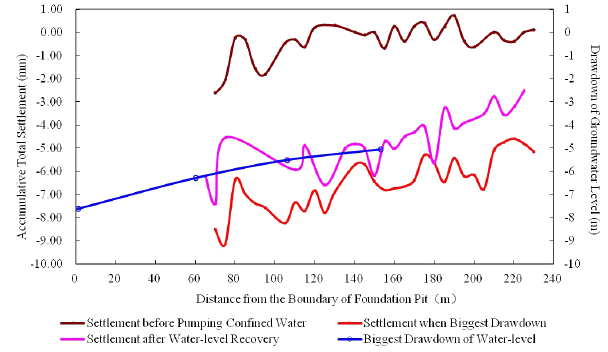
Figure 6. Graphical chart of spatio-temporal features of land sub- sidence and artesian head in monitoring section.